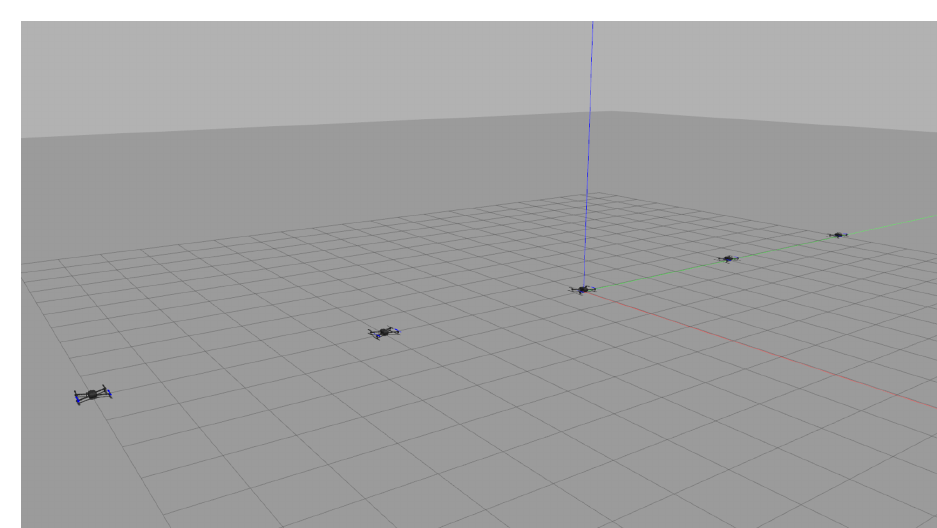
Figure 9. Simulation environment in Gazebo.